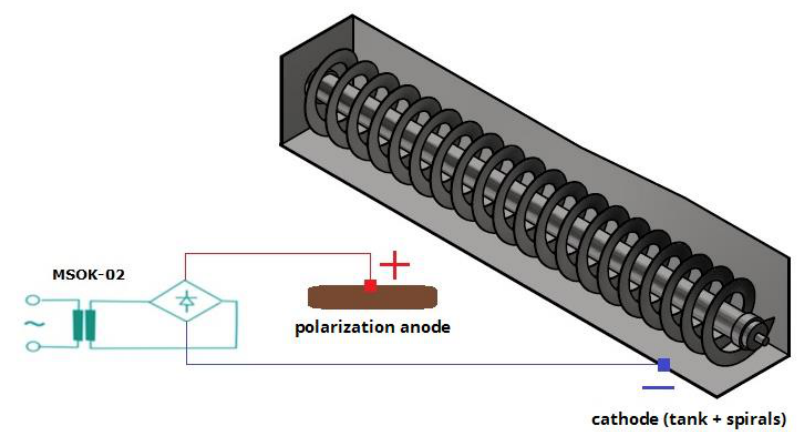
Figure 5. Simplified polarization system diagram—view of a single classifier spiral. The polarizer cabinet, with dimensions of 850 × 1300 × 320 mm and made of a polymer material, was also equipped with a residual current device, a fuse switch, an over- current switch, a protection circuit overvoltage limiter, and a measuring circuit overvoltage limiter (Figure 6).